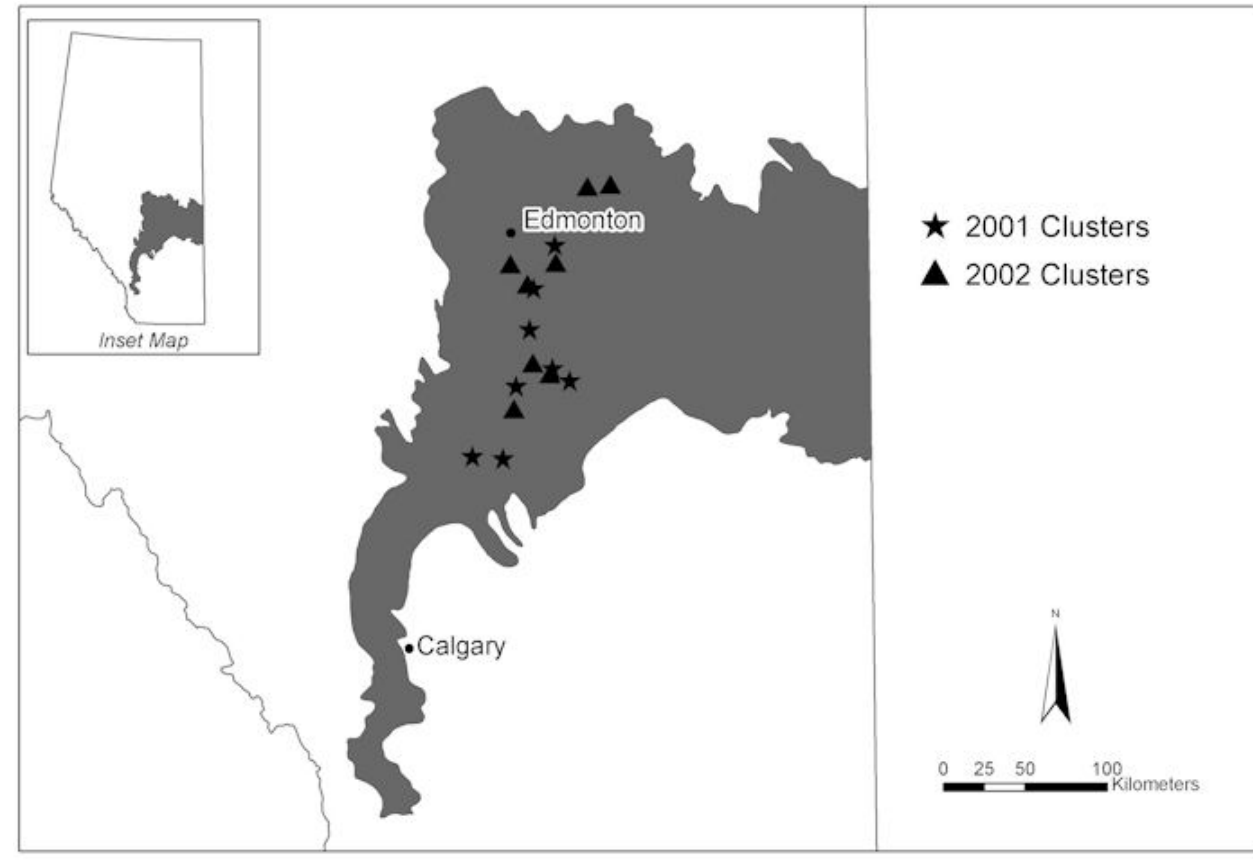
Fig. 1 . Location of study sites in the western Aspen Parkland of Alberta, Canada, 2001–2002. A cluster consisted of a grouping of each of the six treatment types based on grazing intensity (heavy, moderate, and low/idle) and grass type (native/naturalized and